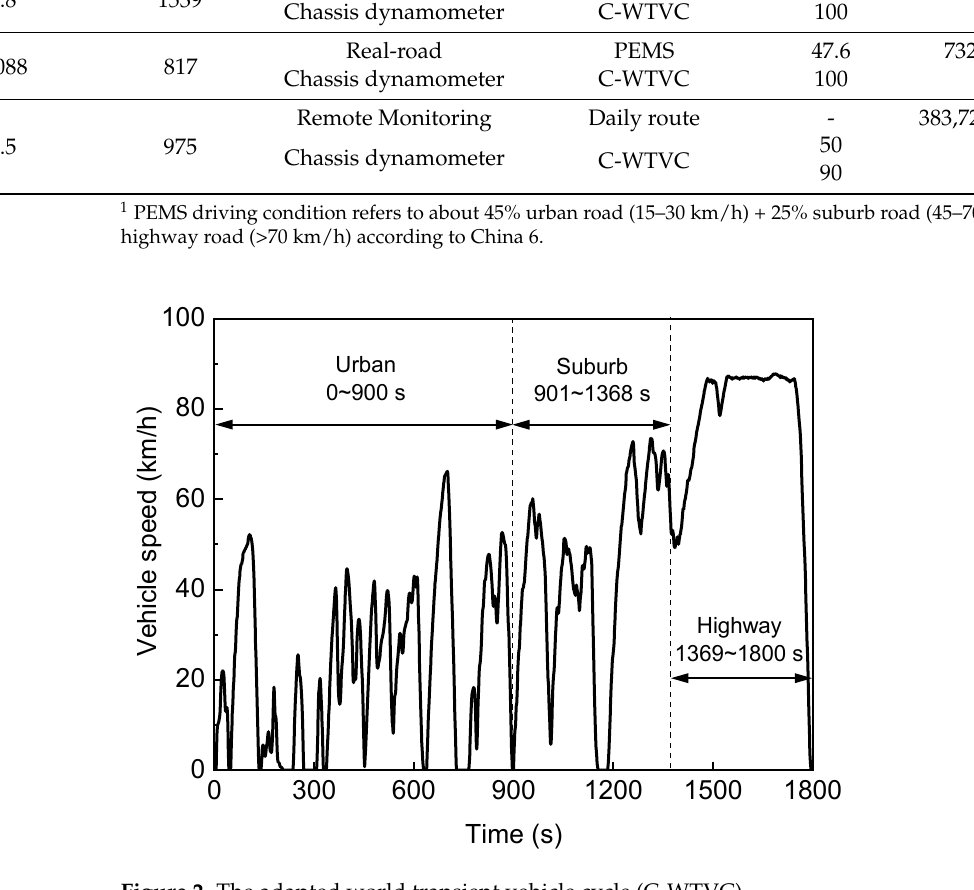
Figure 2. The adapted world transient vehicle cycle (C-WTVC).